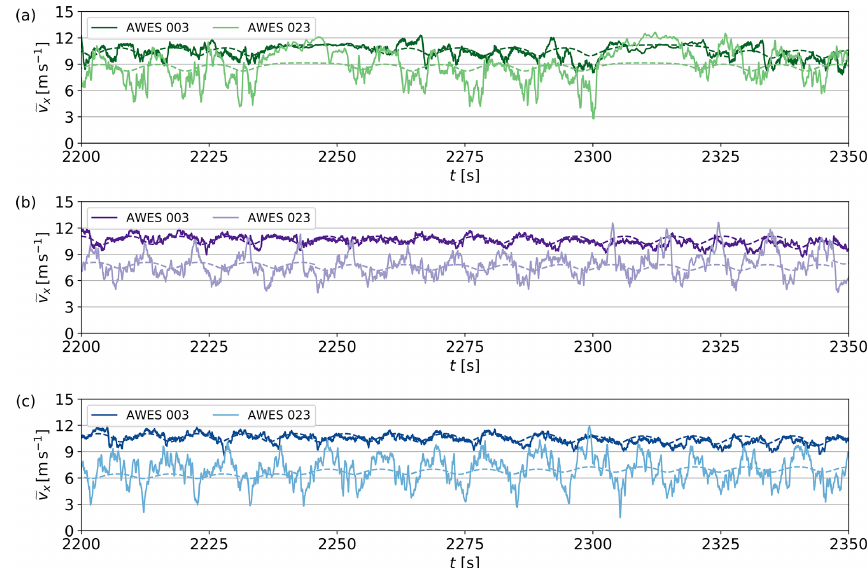
Figure 16. Time series of streamwise wind speed (cid:101) v x monitored by the front and rear AWE systems of the central park column ( x = 2000m) for the AWE parks L1 (a) , D1 (b) , and D2 (c) . The coloured dashed lines show the reference quantities of the tracked trajectories.